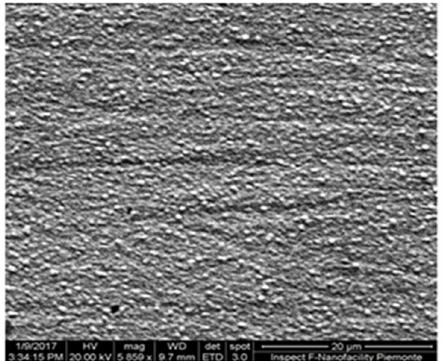
Figure 1. Scanning electrode microscopy (SEM) image of gold nanoparticles modified glassy carbon electrode (AuNPs-GCE) surface (This work has been performed at NanoFacilities Piemonte, INRiM, a laboratory supported by Compagnia di San Paolo).